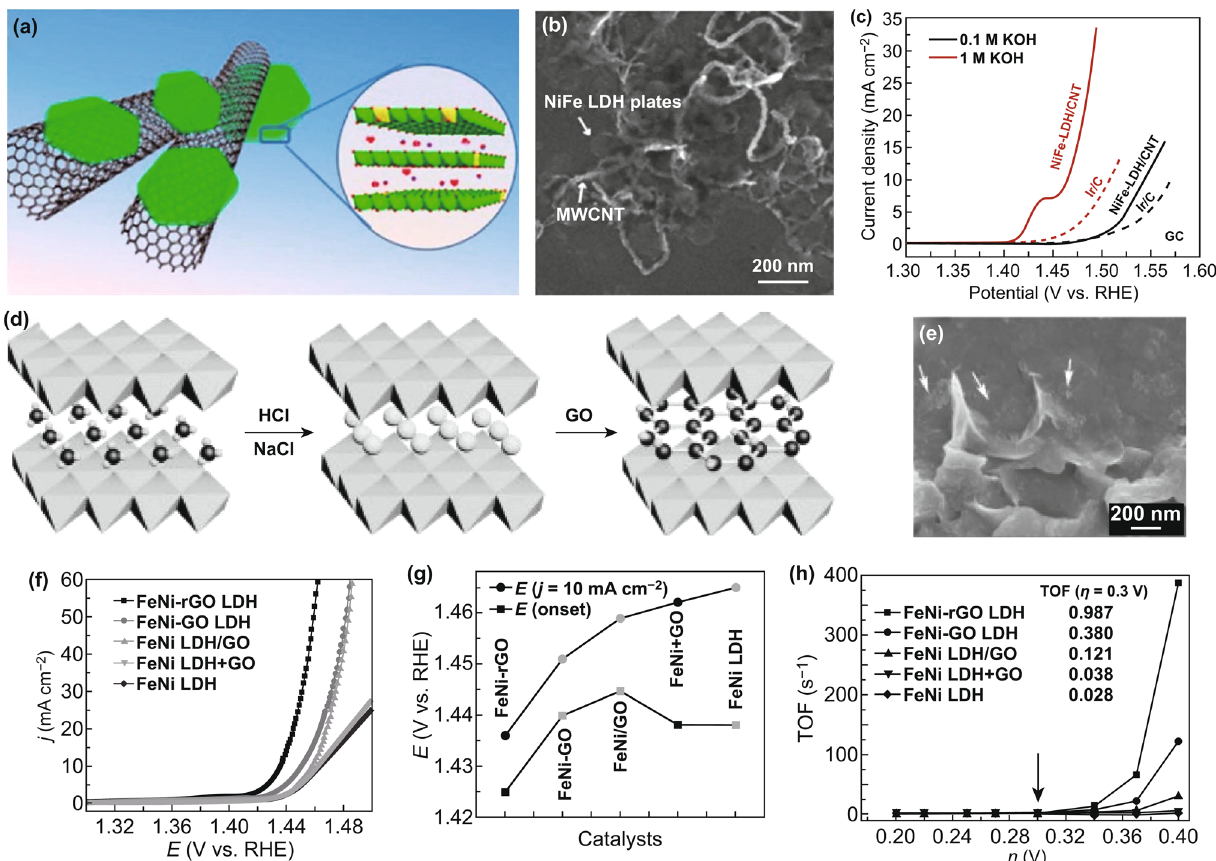
Fig. 9 a Schematic diagrams of the NiFe LDH/CNT hybrid architecture and LDH crystal structure. b SEM image of NiFe LDH/CNT hybrid catalyst. c 95% iR ‑corrected LSV curves of the three catalysts at 5 mV s −1 in 0.1 and 1 M KOH. Reproduced with permission of Ref. [108]. Cop‑ yright 2013 American Chemical Society. d Fabrication process, e SEM image of FeNi‑GO LDHs. f LSV curves of the catalysts at 5 mV s −1